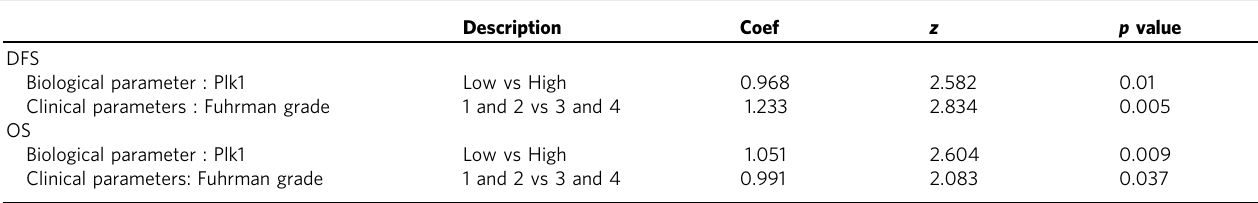
Table 2 Multivariate analysis — ccRCC M0